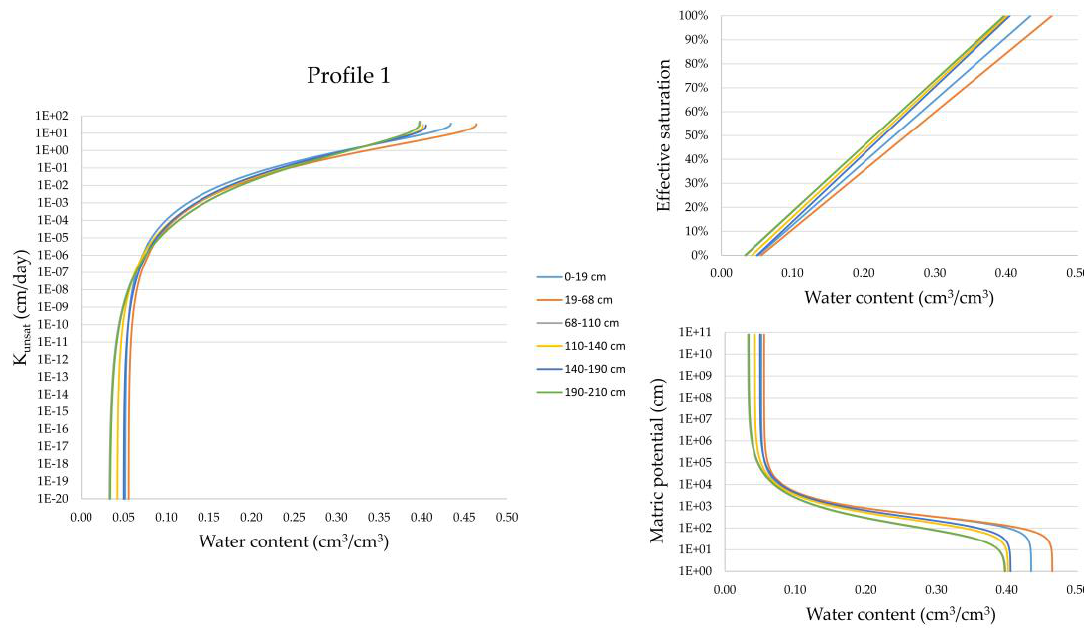
Figure 3. Soil water retention curves (SWRCs), e ff ective saturations, and unsaturated hydraulic conductivities in soil profile 1.